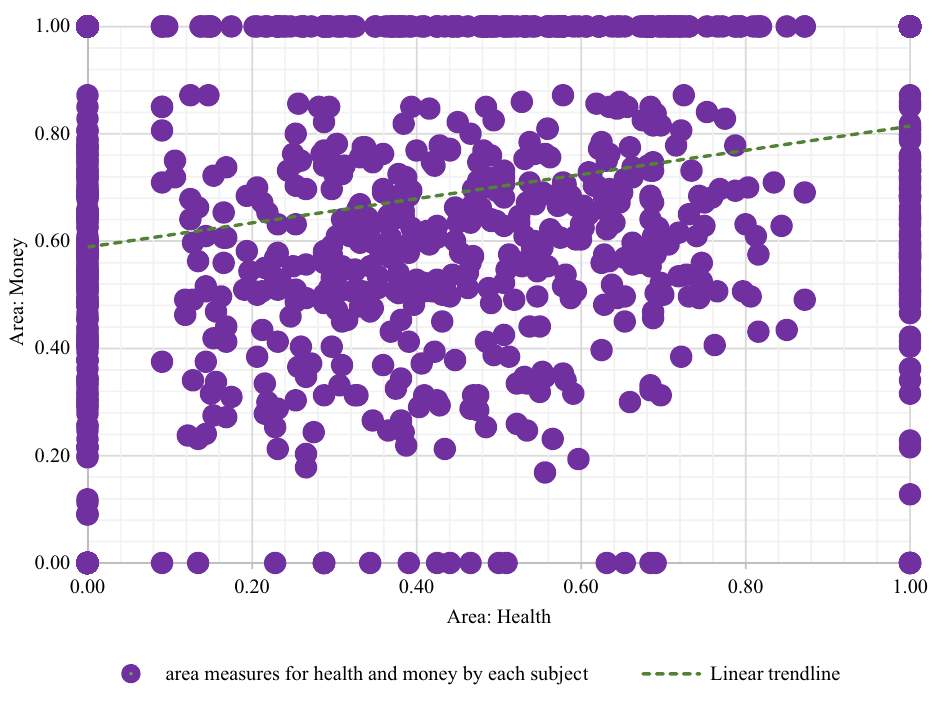
Figure 3. Relation between the area measures for money and health.